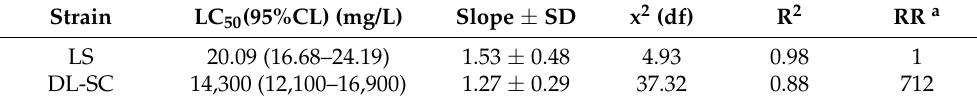
LS: the laboratory susceptible strain; DL-SC: the field spirodiclofen-resistant strain. a Resistance ratio (RR) is expressed as the LC 50 of the resistant strain divided by the LC 50 of the susceptible